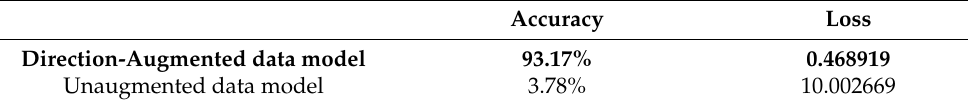
Table 5. Testing Results On Different Trained Models (Wang